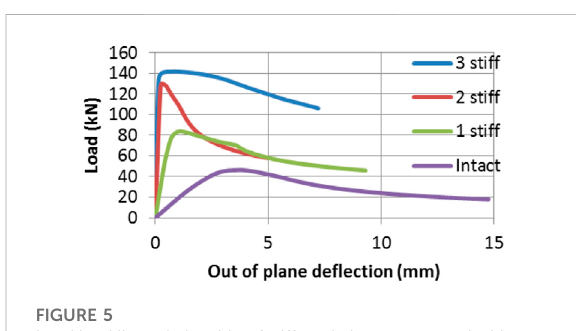
FIGURE 5 Load buckling relationship of stiffened plates compared with the intact plate.